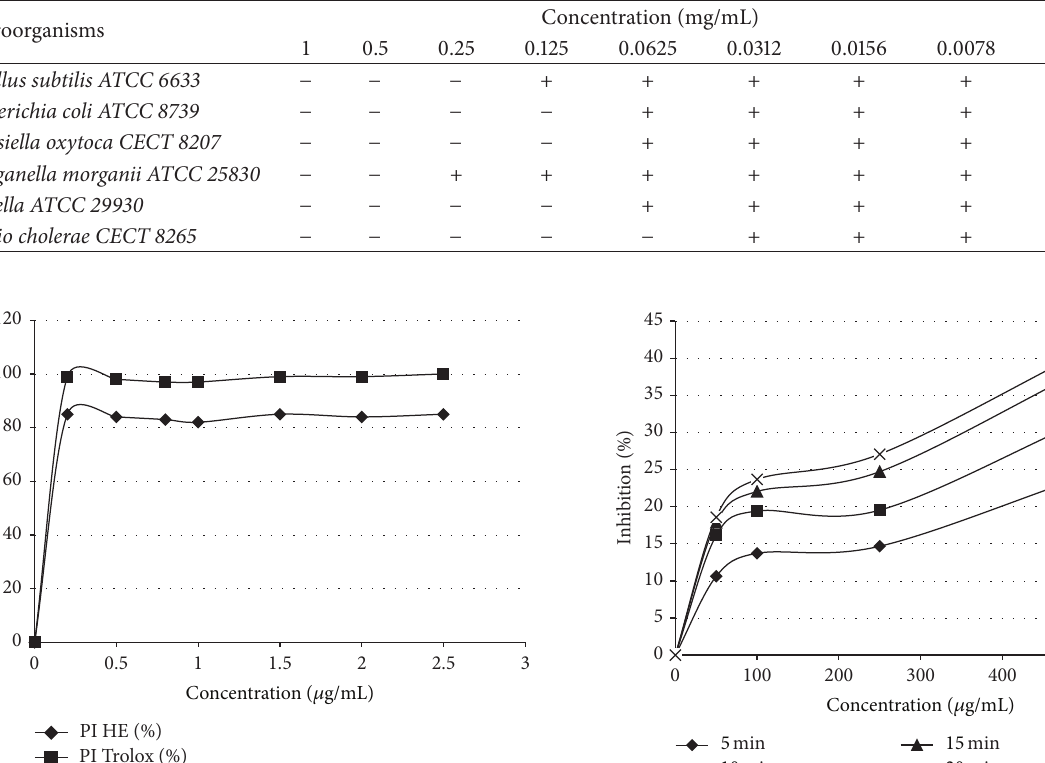
Table 2: Antibacterial activity from essential oil cones of Cupressus sempervirens .